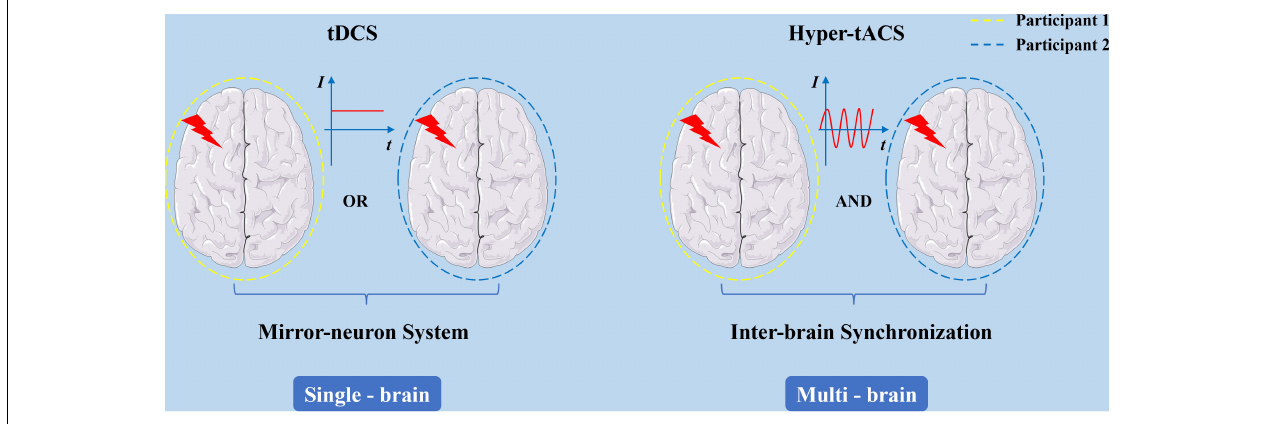
FIGURE 2 | Different intervention patterns of tDCS and hyper-tACS in promoting cooperative